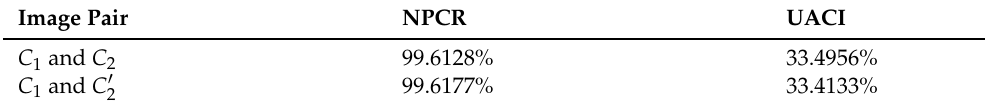
Table 8. NPCR and UACI measures between the cipher images resulting from different